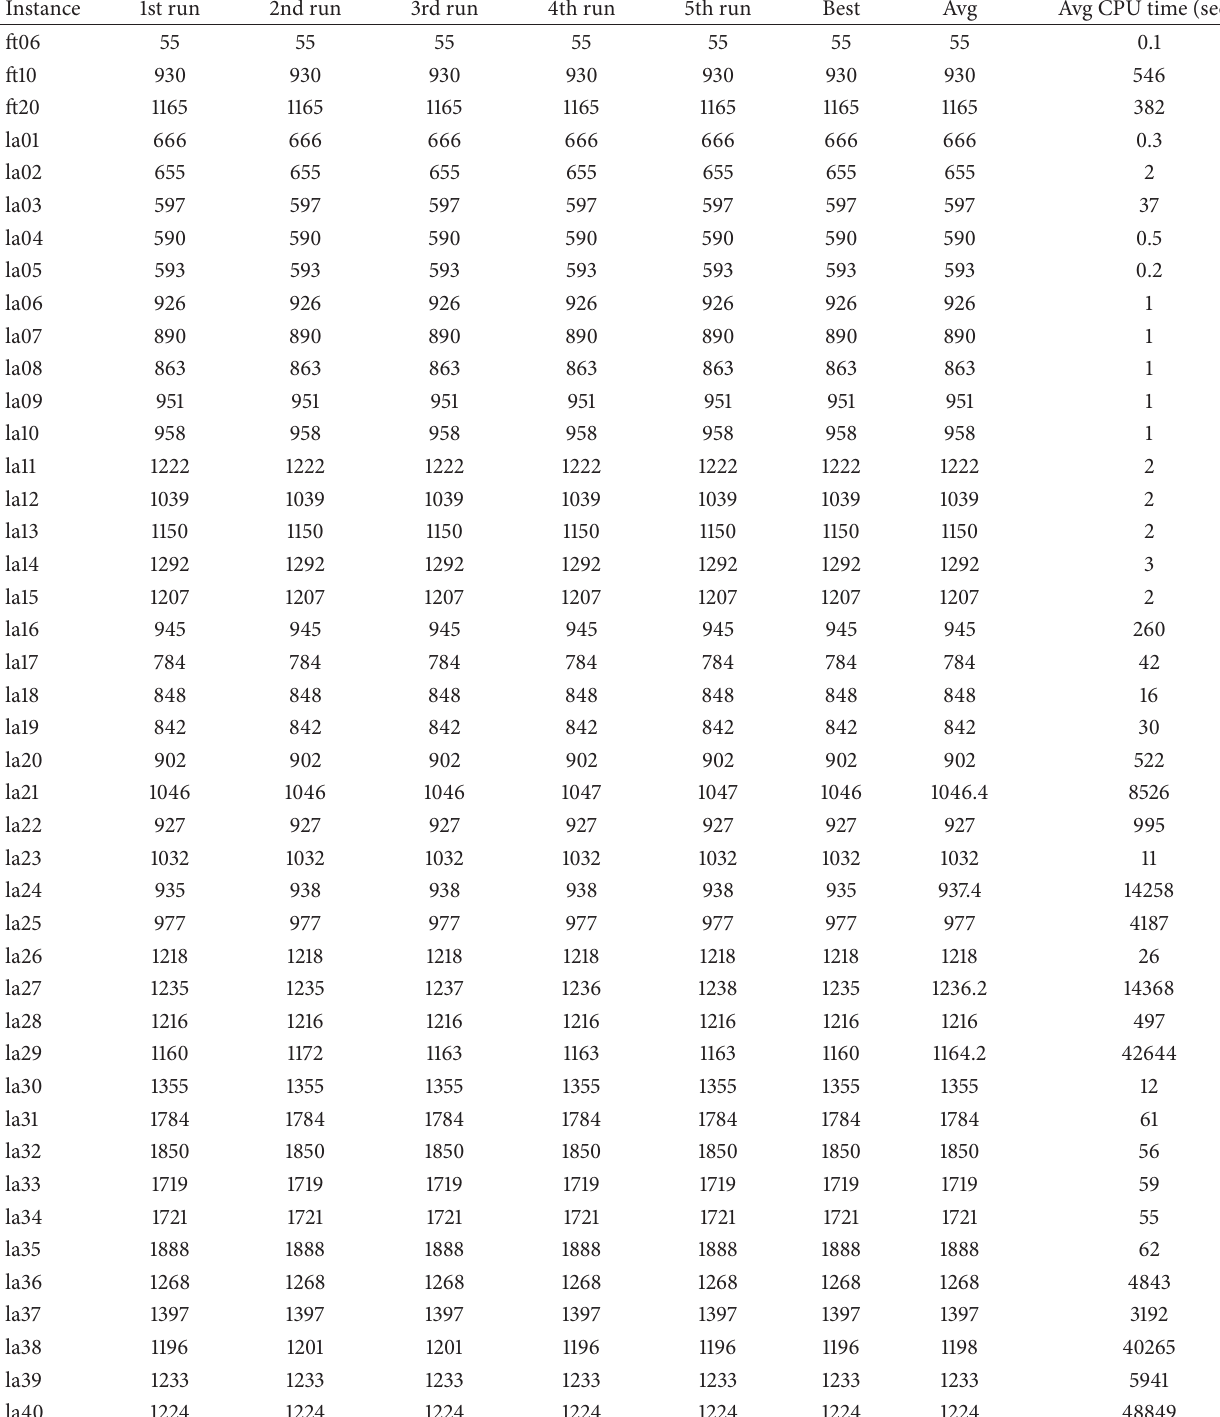
Table 4: Final solution value by each run of the multi-VNS